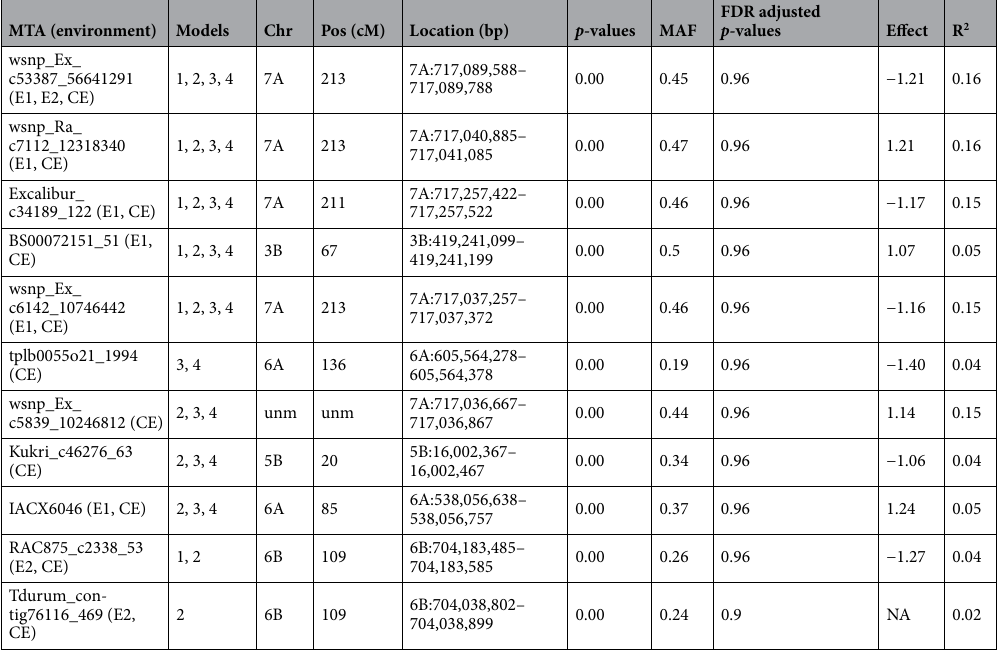
Table 2. Details of eleven significant MTAs identified at threshold [−log10 ( p -value) ≥ 3.0] using all 180 wheat accessions and combined environment (CE) data of E1 and E2. 1, 2, 3, 4 represents MLM, MLMM, BLINK and FarmCPU respectively. Chr chromosome, Pos position, cM centimorgan, bp base pair, unm unmapped, NA not